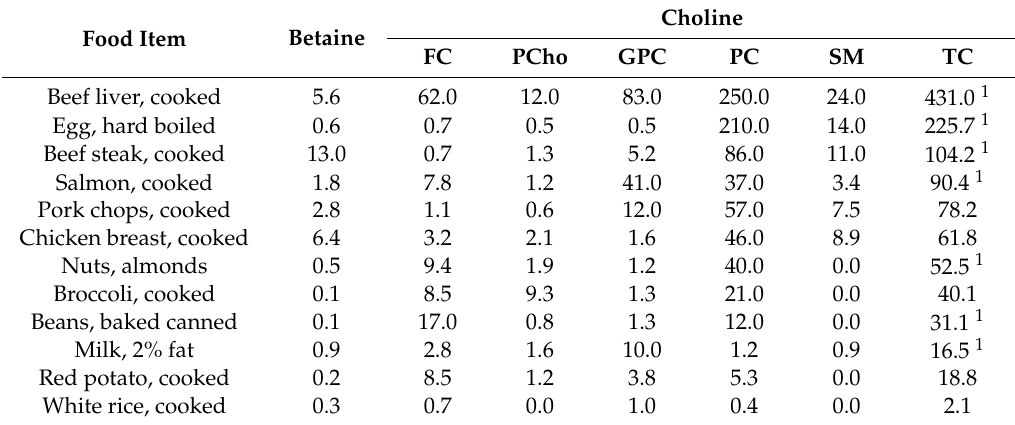
Table 2. Choline and betaine content in different food sources (mg per 100 g of